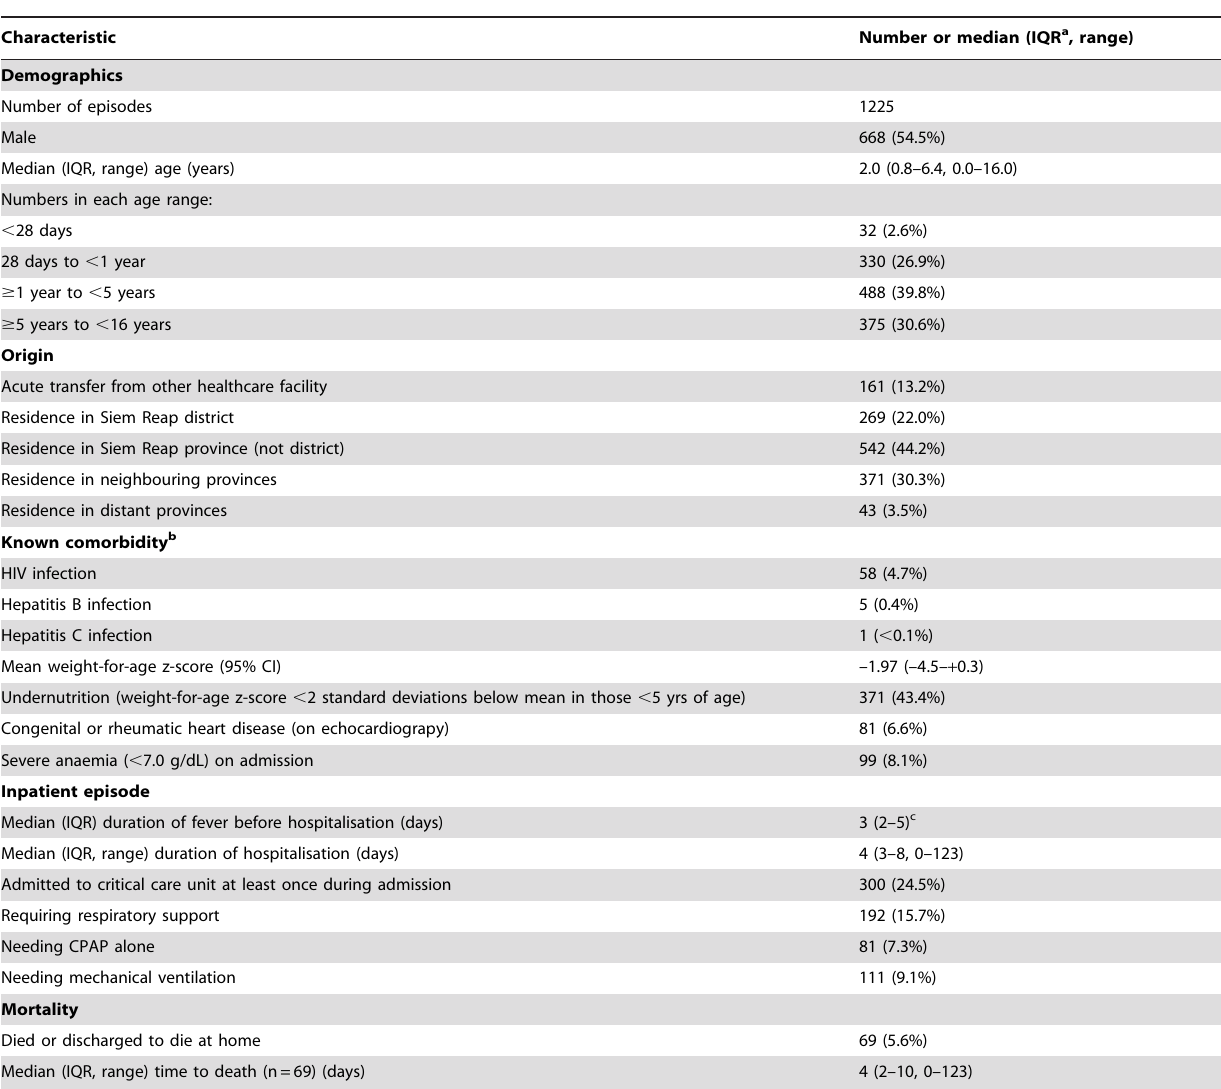
Table 1. Baseline, comorbidity and outcome characteristics in 1225 disease episodes among 1180 children admitted to hospital with fever over one